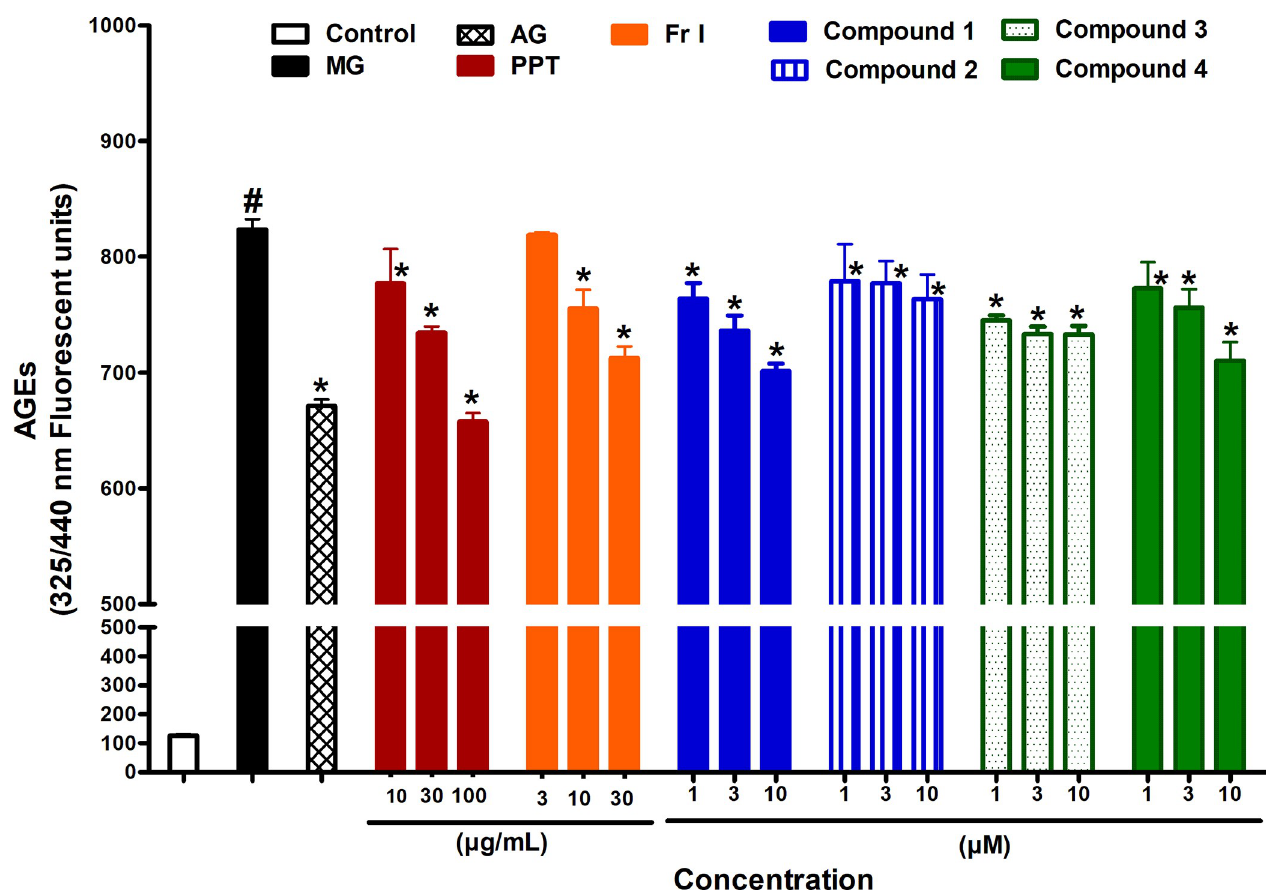
Fig 4. Effect of different concentrations of PPT, bioactive fraction (Fr. I), and isolated compounds 1–4 on the formation of fluorescent AGEs when BSA is incubated with MG for one hour. AG was used as standard anti AGEs drug. Results are expressed as mean ± SEM (n = 3). # p < 0.05 when compared to control group, � p < 0.05 when compared to MG group; by Two Way ANOVA and Bonferroni post hoc test.